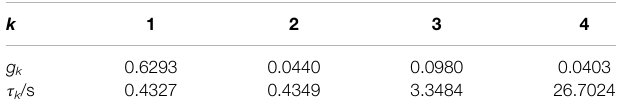
TABLE 2 | Parameters g k and relaxation times τ k for a four-term Prony series to describe the time-dependent decay of stiffness of A30 elastomeric inkjet material. Prony series are supported by nonlinear FE software such as